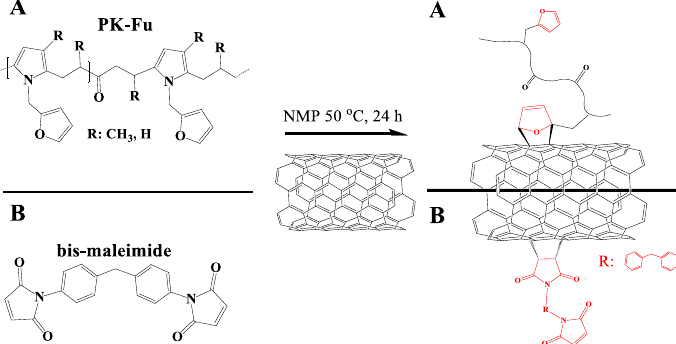
Figure 2. Functionalisation of MWCNTs with ( A ) PK-Fu (diene) and ( B ) bis-maleimide (dienophile) via Diels-Alder reaction.